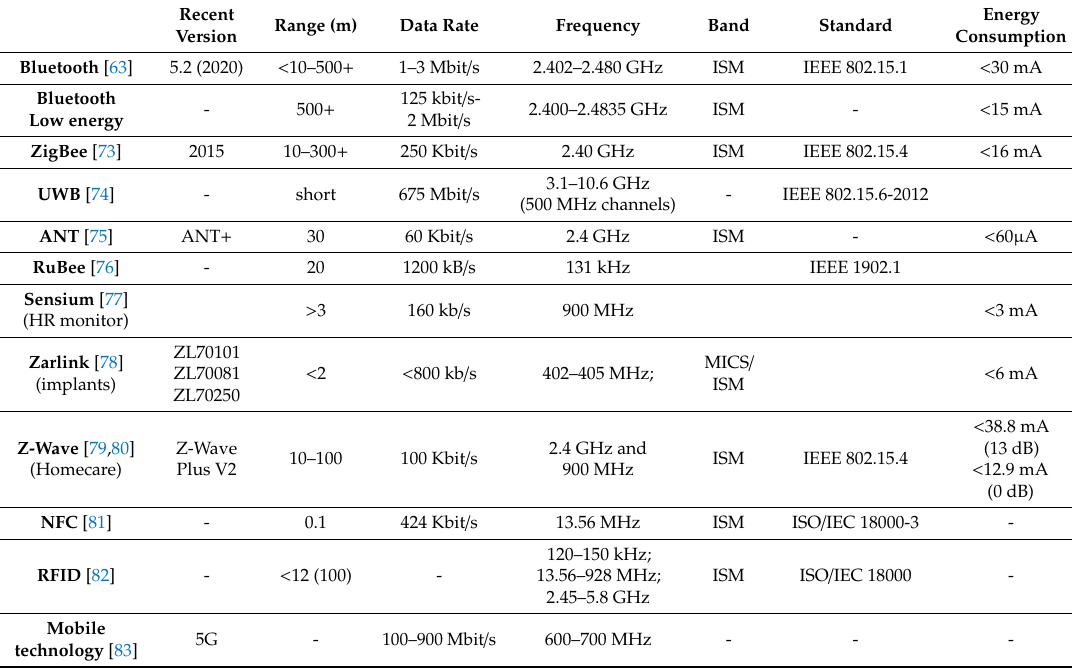
Table 2. Most common wireless communication